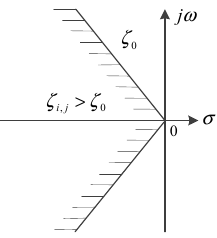
Figure 5. The specified sector region in left half s -plane.